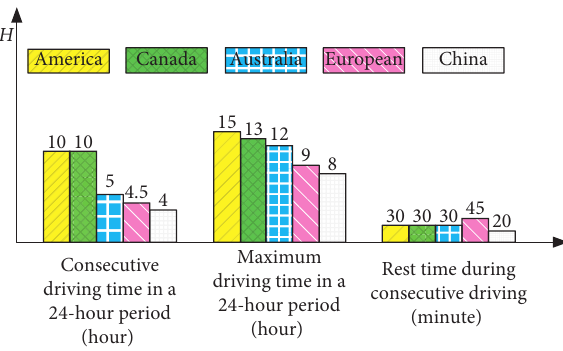
Figure 1: National regulation on driving